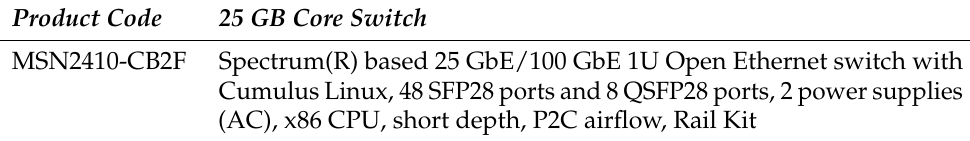
Table 2. Networking